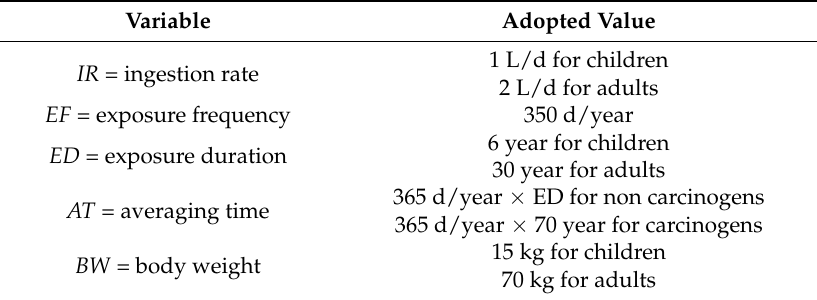
Table 1. Exposure data for the contaminated groundwater